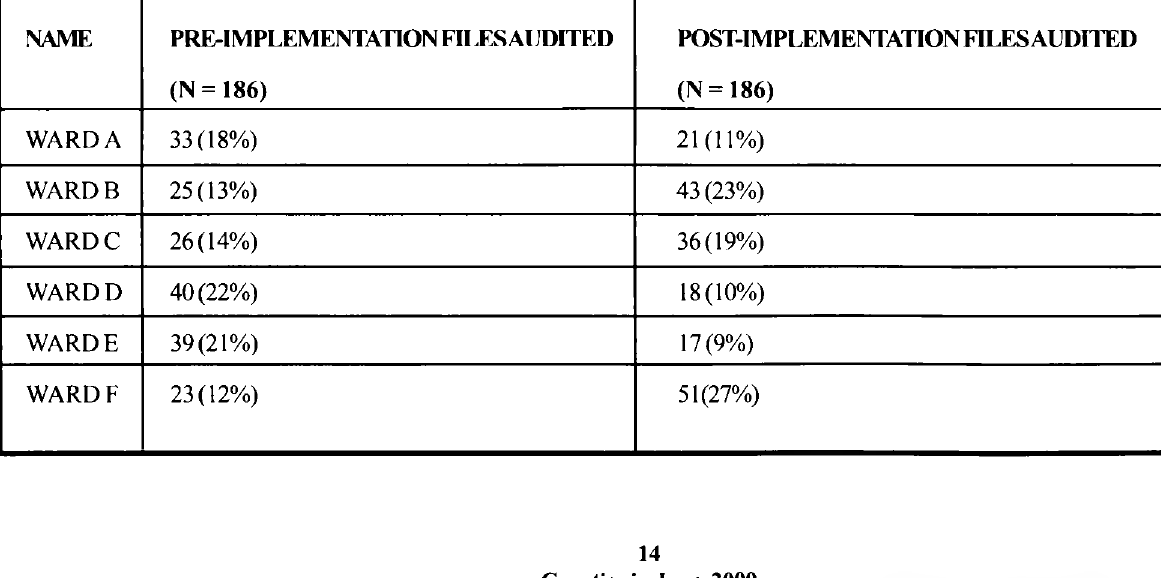
Table 1: Showing the number of files audited per ward pre- and post-implementation